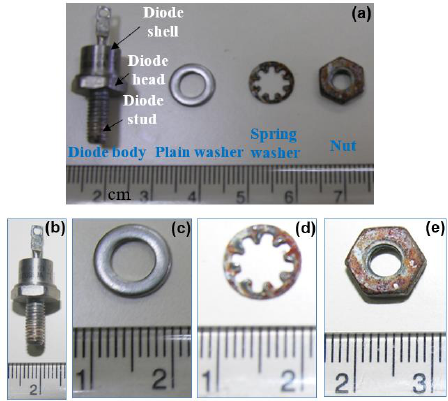
Figure 3: (a) Photographs of diode body, plain Figure 4: (a) Photographs of diode body,